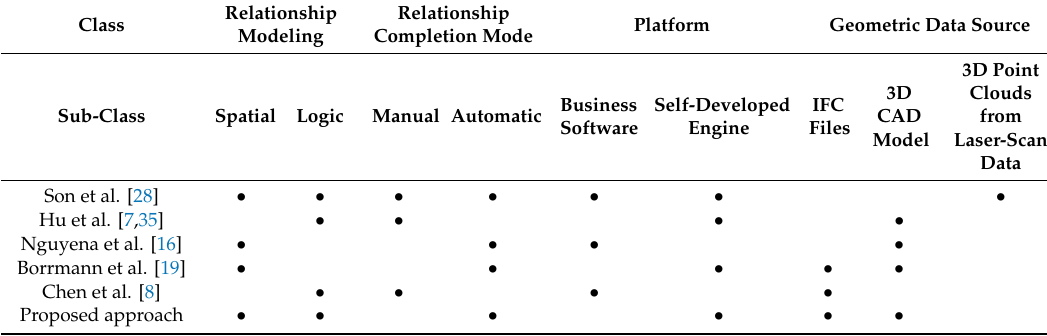
Table 1. Comparison of methods for generating MEP